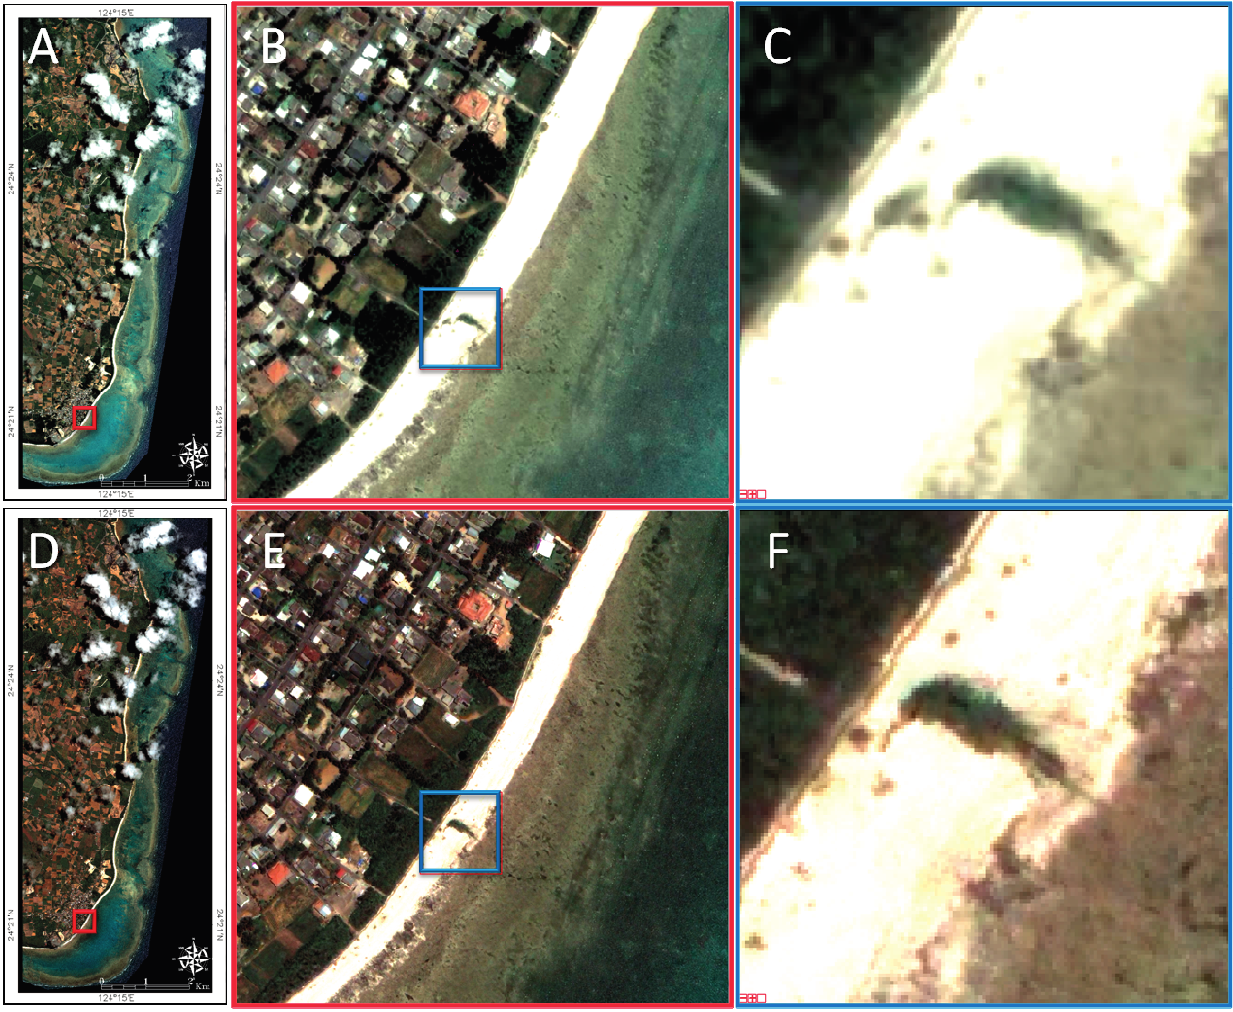
Figure 10. Natural-colored (RGB) images of the entire study area, red square zoom-in and blue square zoom-in stemming from Google Earth-derived very high resolution mosaic ( A , B and C , respectively) and from pansharpened QuickBird imagery ( D , E and F ,